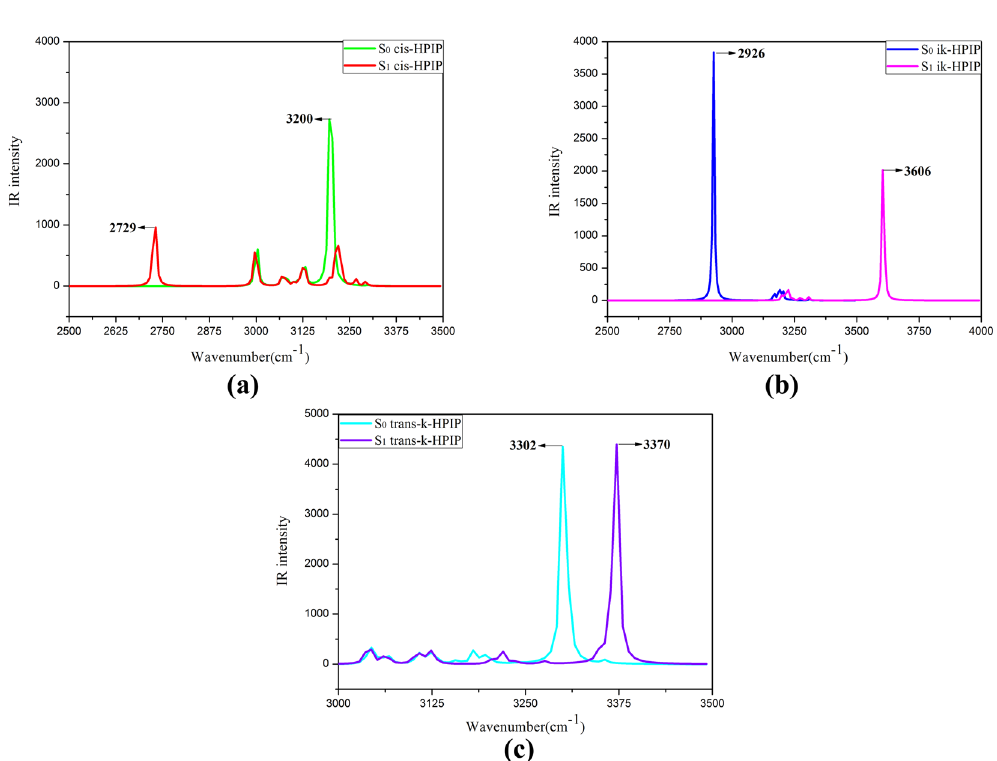
Figure 8. The calculated IR vibrational spectra for ( a ) cis-HPIP in the spectra region of O 1 -H 1 , ( b ) ik-HPIP in the spectra region of N 2 -H 1 , and ( c ) trans-k-HPIP in the spectra region of N 2 -H 1 . The stretching bands of these bonds in the S 0 and S 1 state have been shown. The legend can give reader the detail